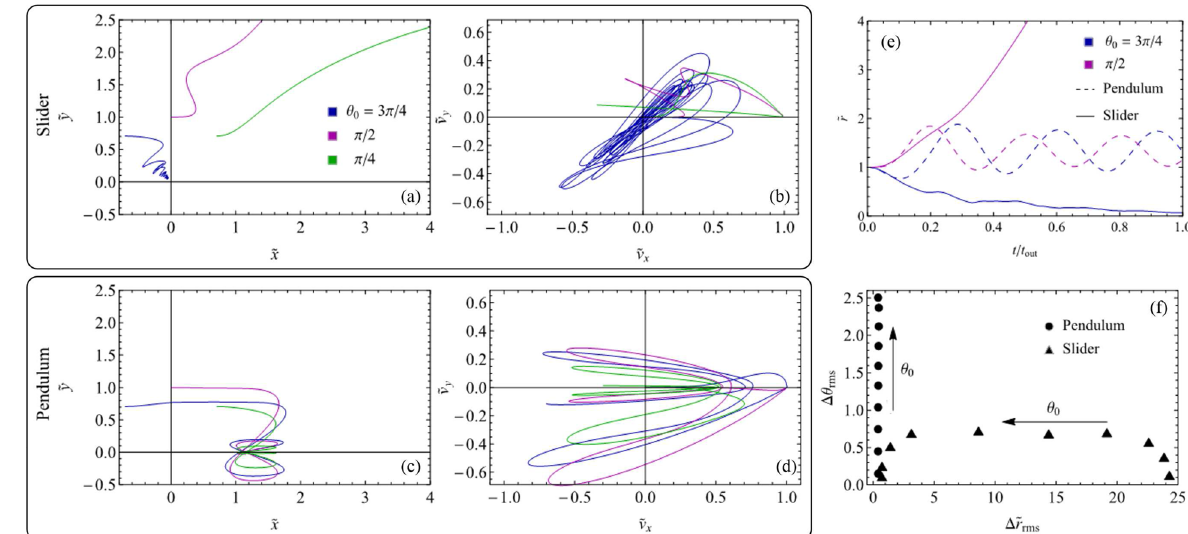
Figure 10. The dynamic behavior of elastic supports extracted from uniform arrays with different static orientation θ 0 . Displacement ( a , c ) and velocity ( b , d ) components for supports belonging to, respectively, the slider ( ˜ k r = 0.01 , ˜ k θ = 3 ) and pendulum ( ˜ k r = 3 , ˜ k θ = 0.01 ) elastic regimes. The time evolution of the dimensionless radial coordinate ˜ r ( e ) for supports in the previously mentioned elastic regimes with different θ 0 . The values of �θ rms and (cid:31) ˜ r rms associated with the dynamics of different supports during the whole sliding against the rigid slab under different elastic regimes. Results refer to ˜ F N = 1